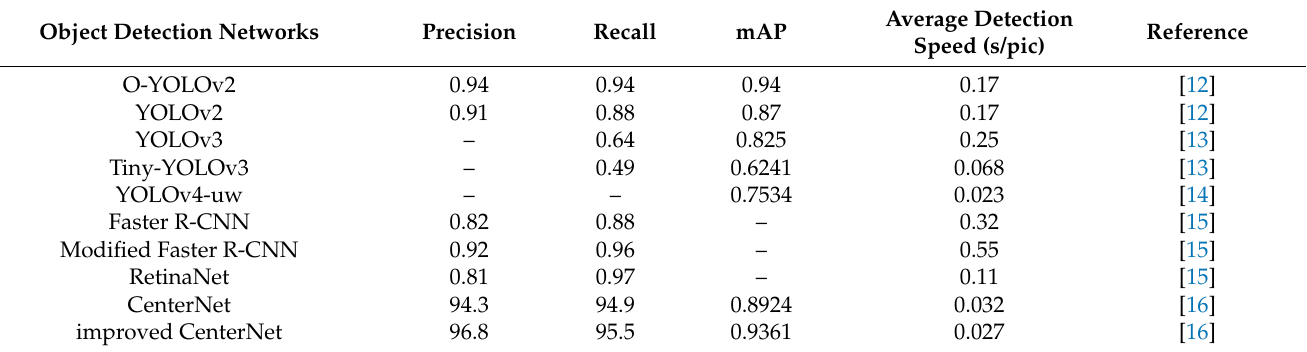
Table 1. Comparison of different models for wildlife